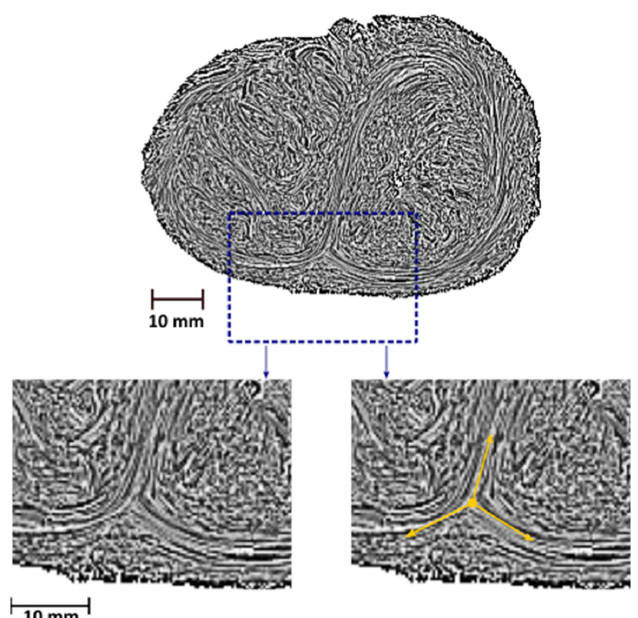
Figure 4. Left ventricular apex and +1 disclination. Apical sections of a perinatal heart (29 gestational weeks). The LV vortex (“+1 disclination”) is observed in the LIC map ( A ), in the azimuth map ( B ), and in the elevation map ( C ). The spiral ( D ) and the vector field ( E ) are superimposed at A, in order to help the reader to visualize the “+1 disclination”.